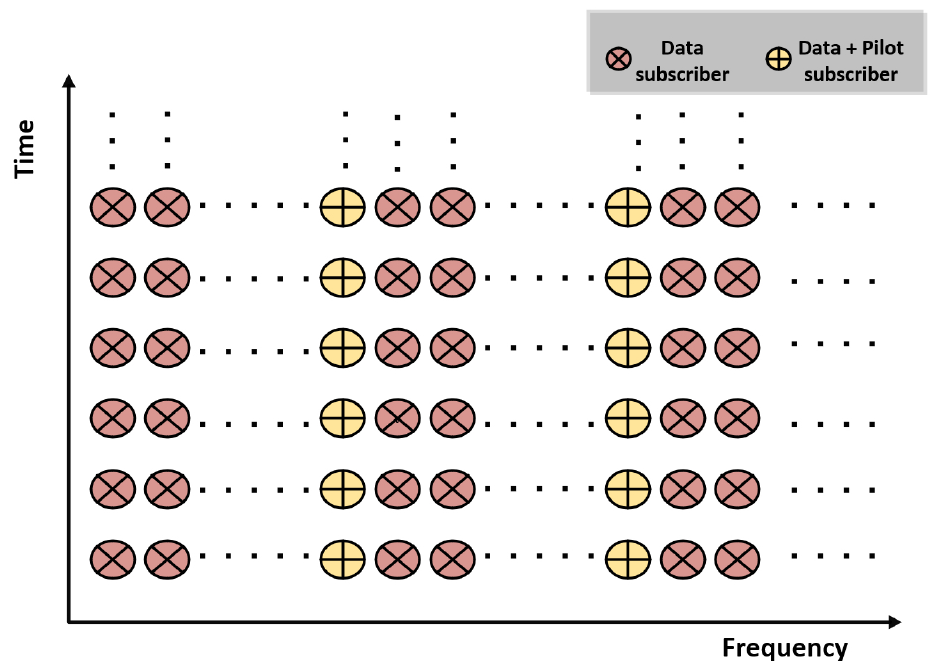
Figure 3. Block structure of eOFDM